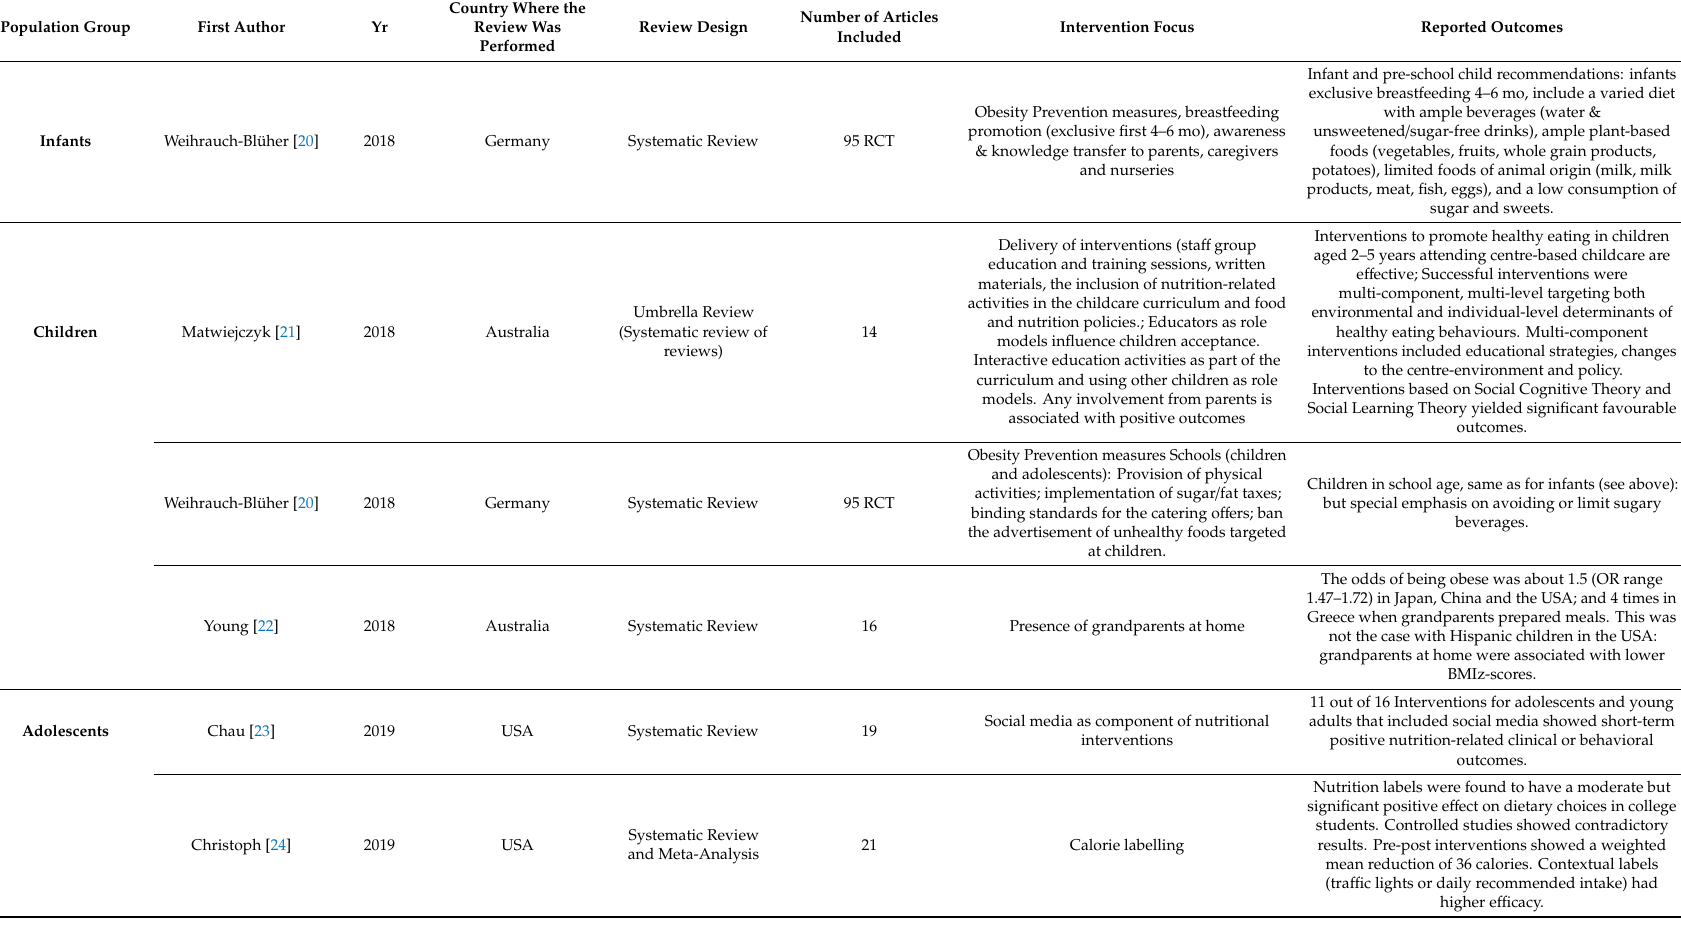
Table 1. Characteristics of the reviews